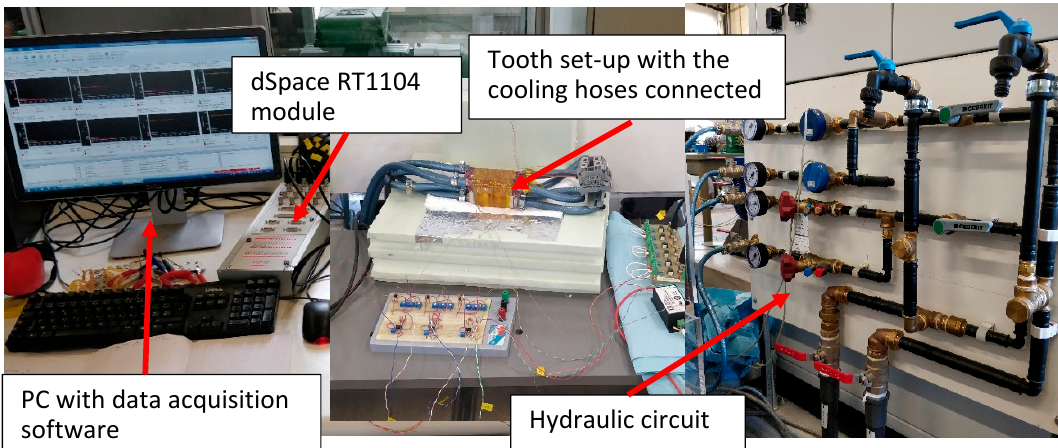
Figure 15. Complete measurement set-up and the hydraulic circuit used for cooling.